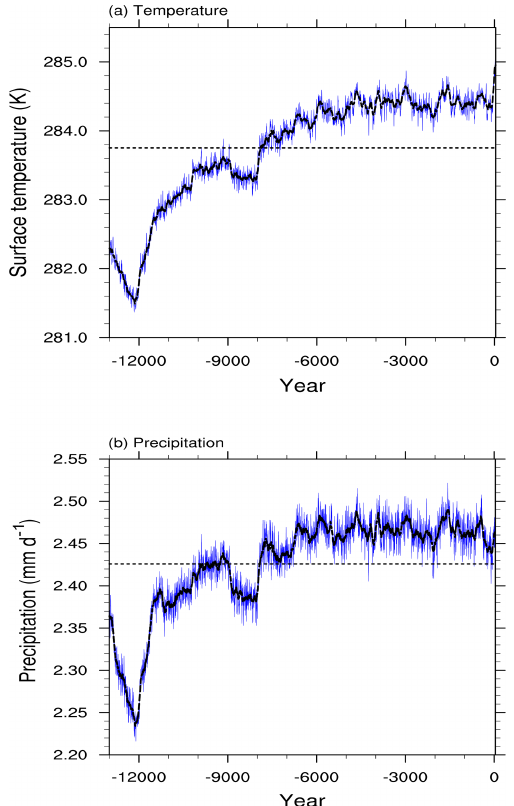
Figure 1. (a) Northern Hemisphere average surface temperature and (b) precipitation over the last 13kyr from the all-forcing exper- iment. The blue line is the 10-year running average and the black line is the 100-year running average. The black dashed line shows the average of the time